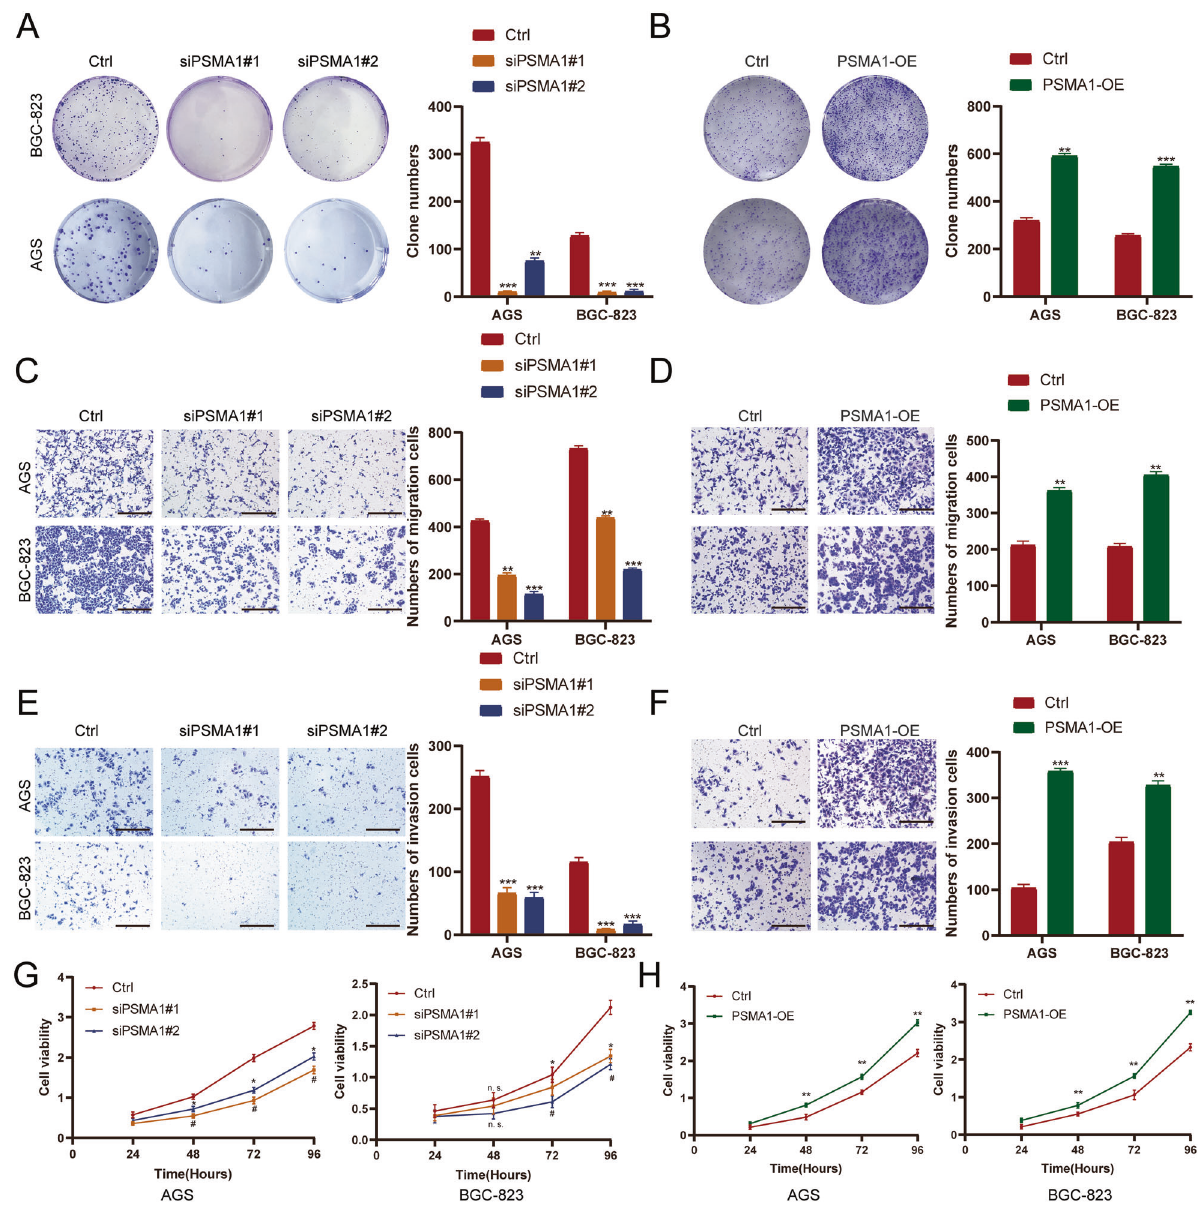
Fig. 4 PSMA1 promoted the proliferation, migration, and invasion of GC cell lines. A Colony formation assay was performed to detect the proliferation of knock-down PSMA1 and control GC cells. B Colony formation assay was performed to detect the proliferation of over- expression PSMA1 and control GC cells. C , E Invasion and migration assay were performed to detect the proliferation of knock down PSMA1 and control GC cells. Bar length: 100 μ m. D , F Invasion and migration assays were performed to detect the proliferation of over-expression PSMA1 and control GC cells. Bar length: 100 μ m. G The CCK-8 assay was used to detect the proliferation of knock-down PSMA1 and control GC cells. H The CCK-8 assay was used to detect the proliferation of over-expression PSMA1 and control GC